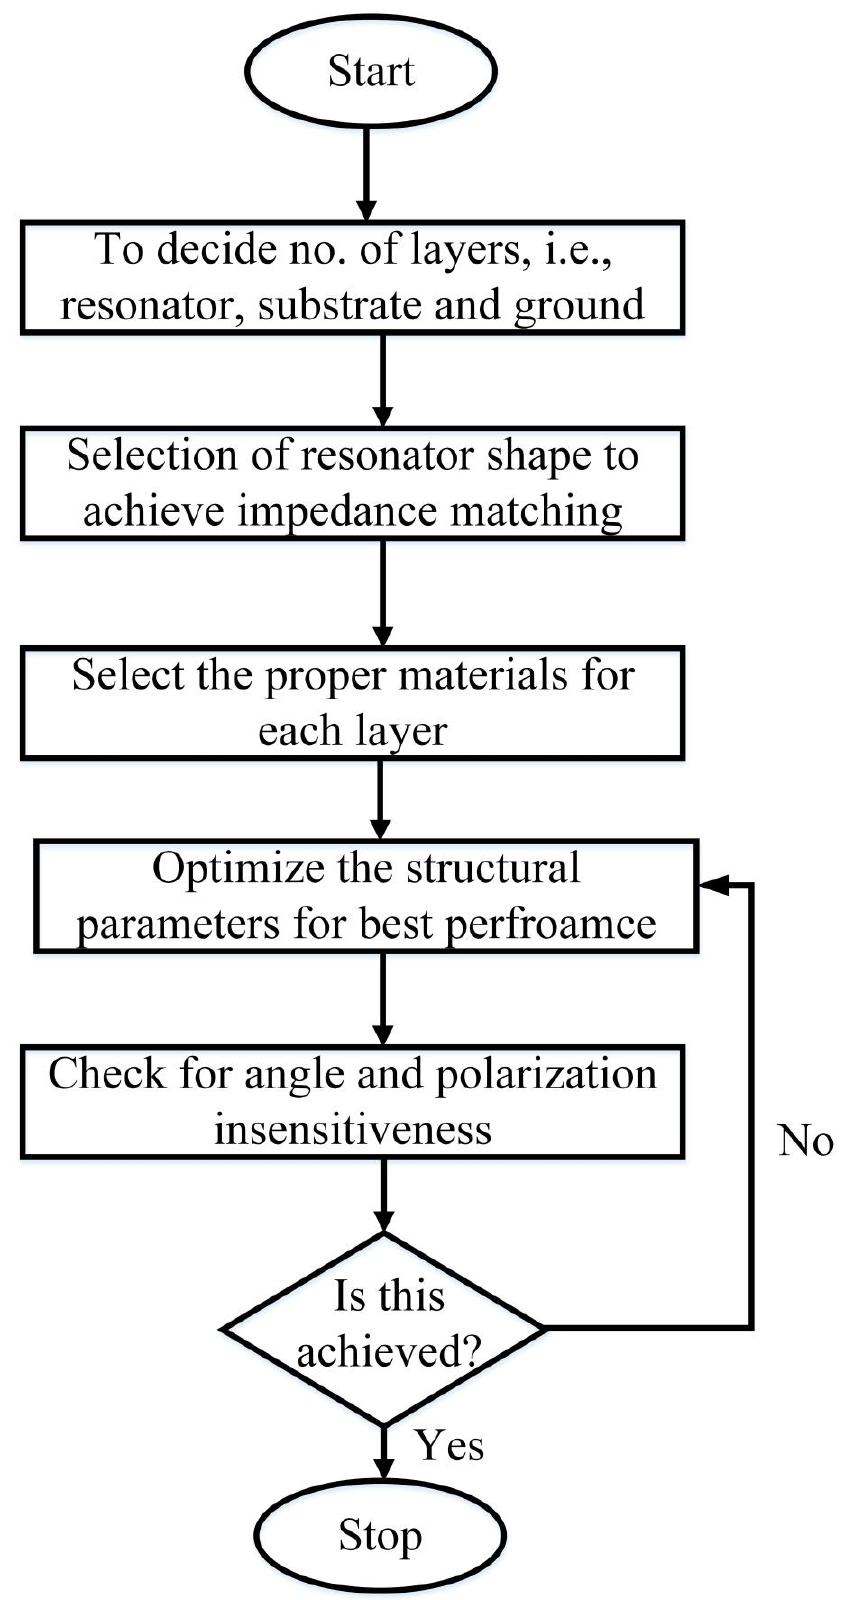
Figure 1. Flowchart describing the design process of the proposed broadband solar absorber.